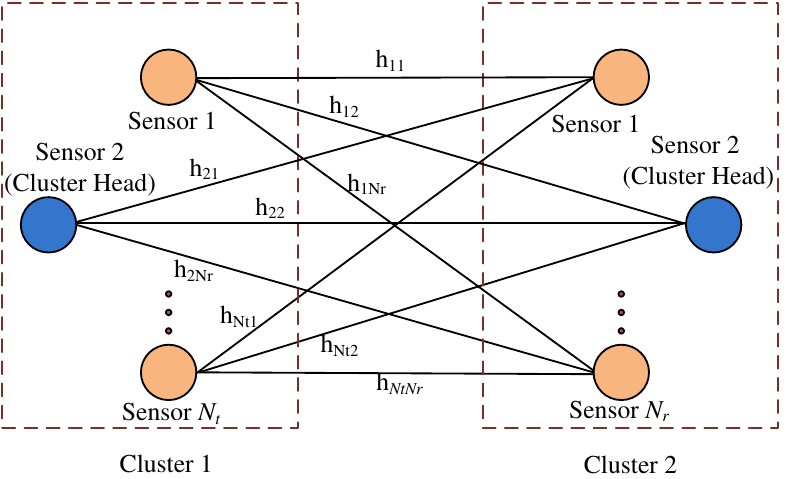
Figure 1. System model for cluster to cluster communication in wireless sensor